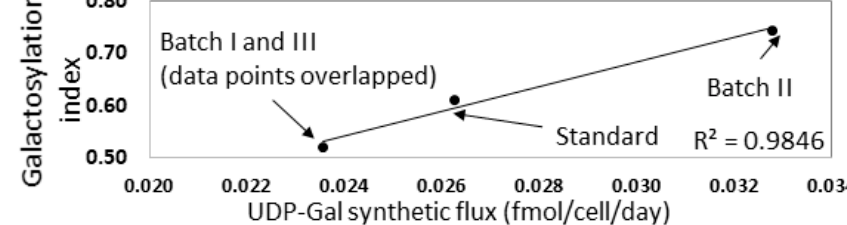
Figure 6. FBA results. ( A ) Flux distribution in the central metabolism network for four batches. ( B ) Fluxes of the reactions associated with glycosylation. ( C ) The linear correlation between UDP-Gal flux and the overall galactosylation level.